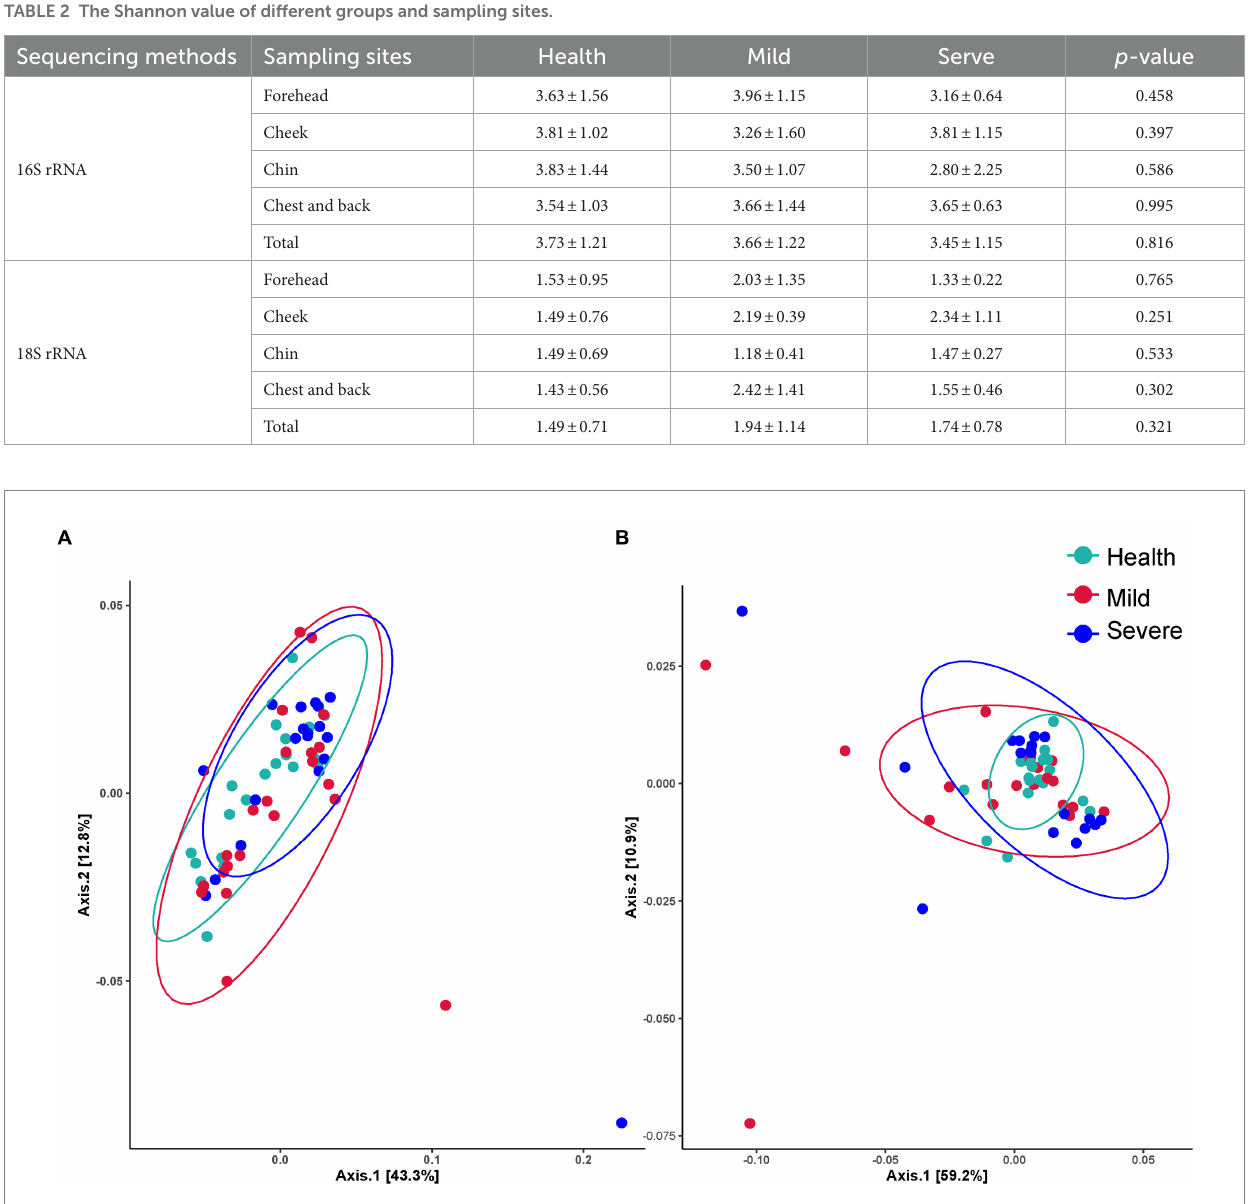
FIGURE 1 The beta diversity between the health, mild acne, and severe acne groups. (A) Bacteria flora. (B) Fungal